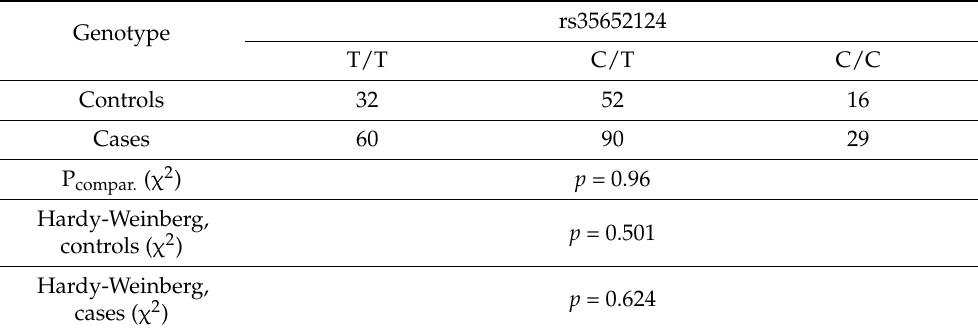
Table 2. Allelic frequency distributions in six SNP sites in ASD cases and normal